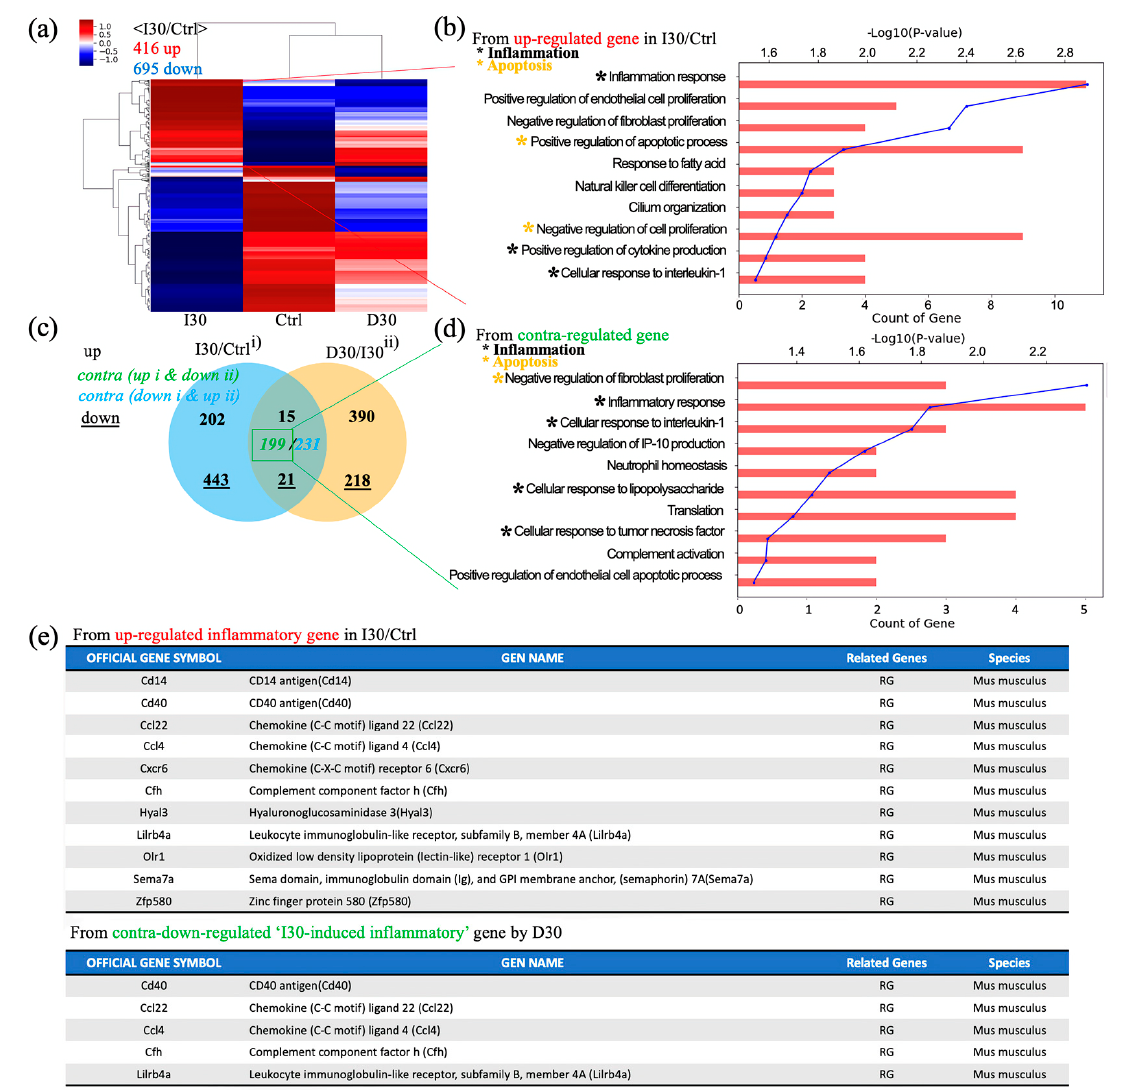
Figure 6. Global gene expression study using quant-sequencing to identify transcriptome features with I30, Ctrl, and D30 under osteoclast differentiation media. ( a ) Distance-based clustering analysis from global transcriptional changes in 3 groups with 1.2-fold change and over 1 log2 value from differentially expressed gene between I30 and Ctrl. The transcriptome profile with I30 differed from Ctrl and D30L. ( b ) Gene ontology (GO) analysis using up-regulated genes in I30L compared to Ctrl. Biological process analysis showed that major GO related to active inflammation and apoptosis (negative regulation of proliferation) was enriched in I30L. ( c ) Venn’s diagram of the comparison of differential gene expression based on Quant-seq data with numbers of co-up or –down and contra- regulated genes. ( d ) GO analysis using contra-regulated genes (I30L/Ctrl up-regulation & D30L/I30L down-regulation). Biological process analysis showed that major GO related to active inflammation and apoptosis (negative regulation of proliferation) were assigned in down-regulated genes by D30L, meaning a decrease of inflammation and apoptosis could occur in D30L compared to I30L. These transcriptome results support less osteoclast differentiation of precursors in D30L compared to I30L. Collectively, these results indicate that I30L stimulated osteoclast formation, while D30L suppressed the formation of osteoclasts in an in vitro study. ( e ) Inflammatory gene sets. Among 11 inflammatory up-regulated genes in I30/Ctrl, CD40, ccl22, ccl4, cfh, and lilrb4a were down-regulated by D30, supporting less osteoclastic differentiation potential of D30 than